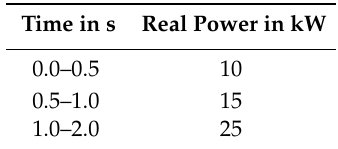
Table 3. DC load connection details.